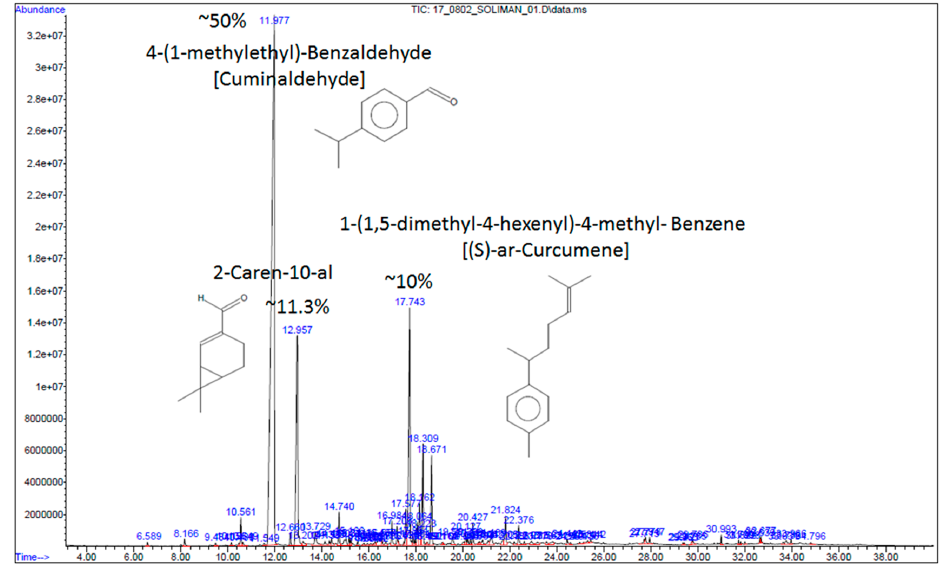
Figure 3. GC-MS analysis of Calli oil. The analysis showed that 4-(1-methylethyl)-benzaldehyde, 2-caren-10-al and 1-(1,5-dimethyl-4-hexenyl-4-methyl-benzene were the three major components of Calli oil. Y axis represents the abundance of the peaks.